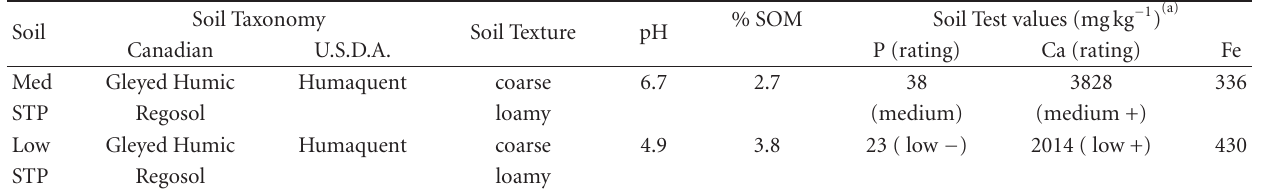
Table 1: Selected properties of Medium-Soil Test P (Med-STP) and Low-Soil Test P (Low-STP) soils used in the study. Lab analysis was performed on the bulked, dried, and sieved soil.